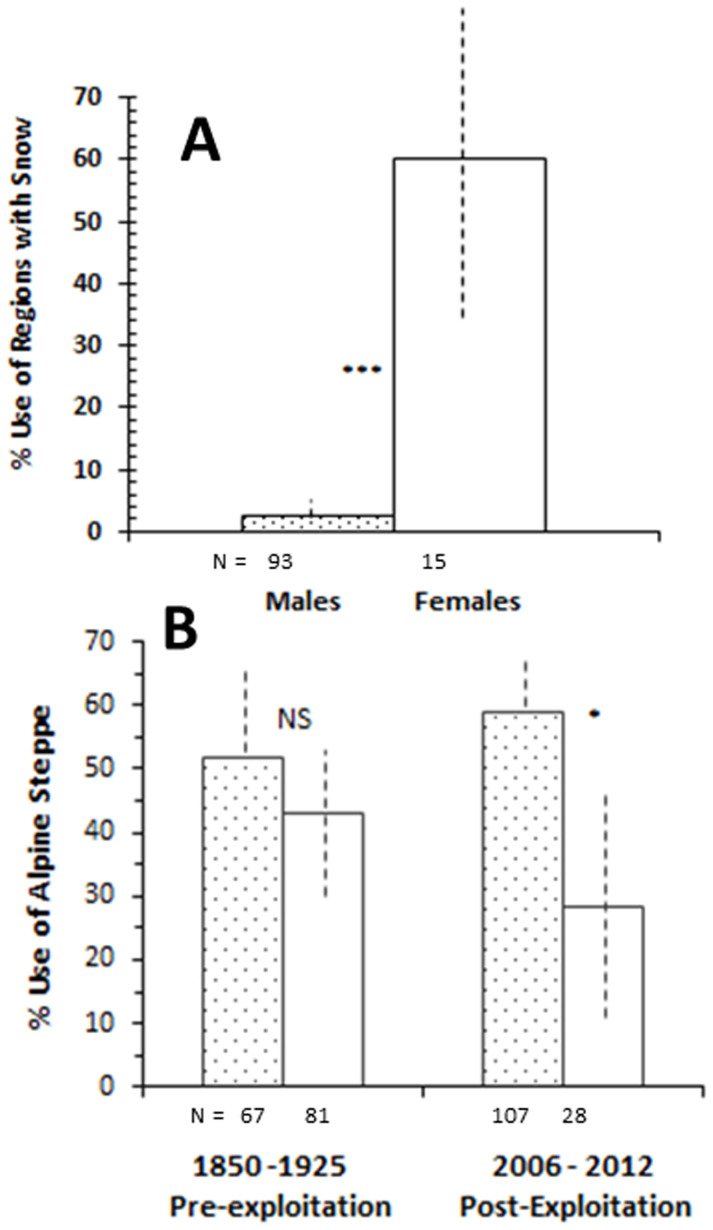
(A) Percent usage of areas within 200 m of snow patches by male and female yak groups in 2012 (P < 0.0001). (Odds ratio = 46.50; z = 4.869; for females 95% CI = 35.21% to 84.79% (±24.79); Males 95% CI = −0.37% to 6.81% (±3.59). (B) Temporal changes in female and male yak groups. Baseline (pre-exploitation) period generated from 148 historical and post-exploitation data from recent fieldwork in 2006 and 2012. Sex differences in pre-exploitation period NS, but *P = 0.004 during post-exploitation.